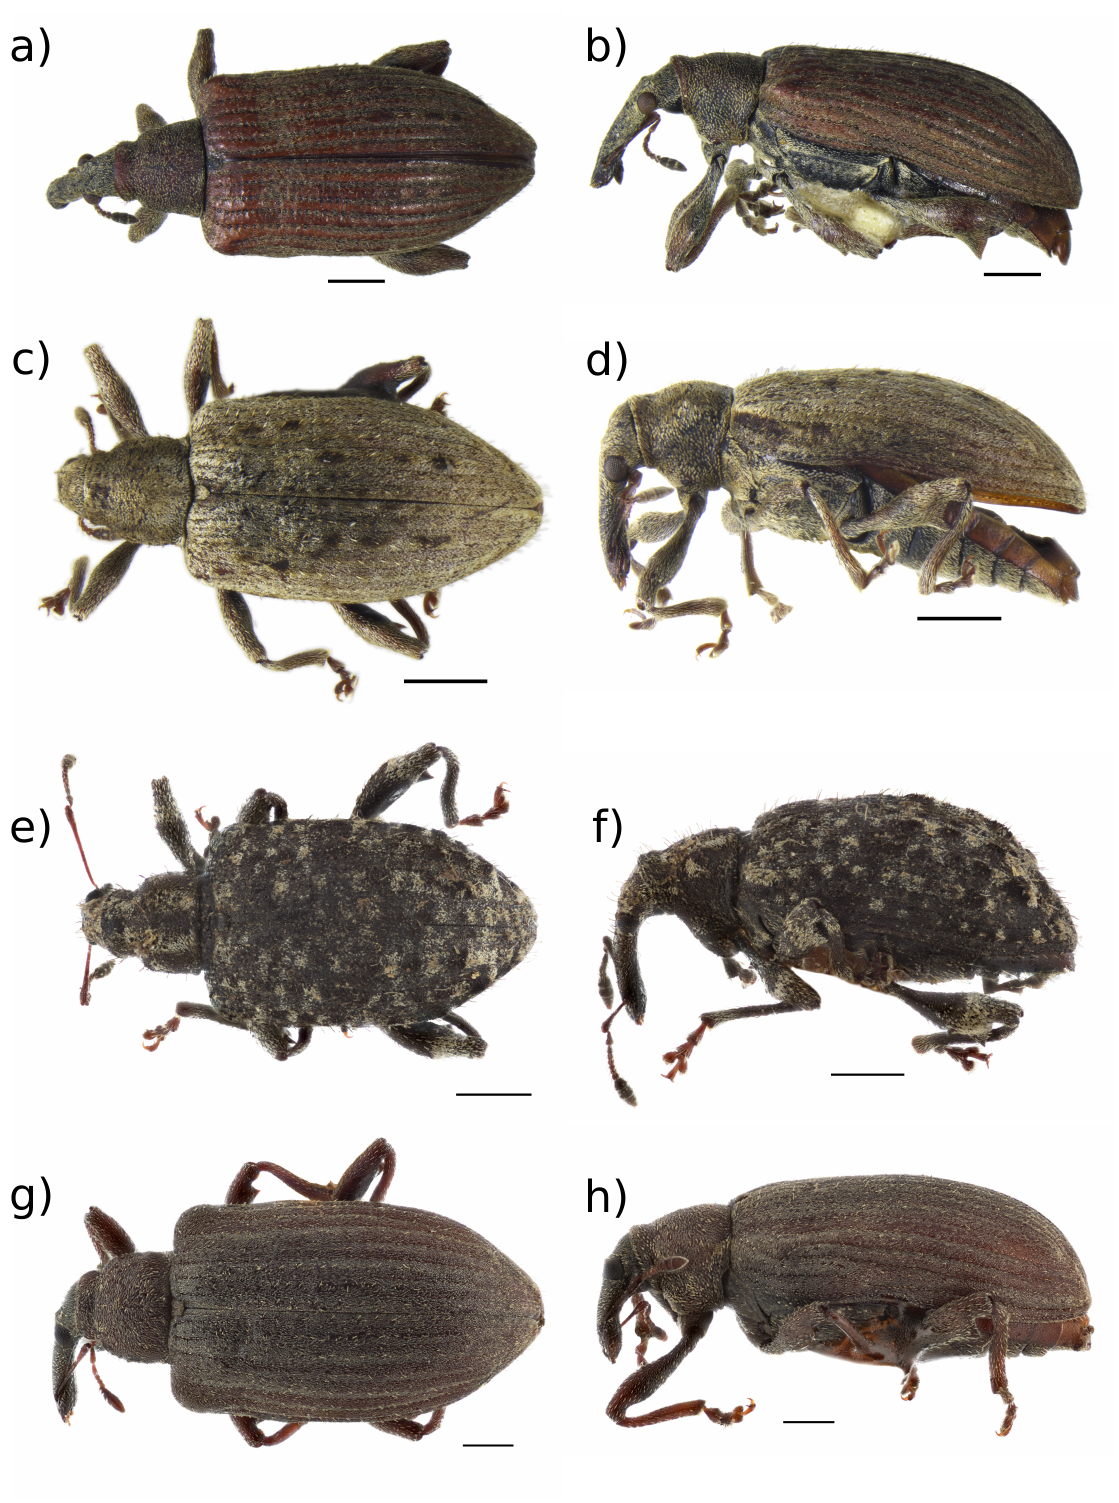
Figure 2. Habitus figures of Kuschelysius species. ( a ) K. hollowayae , dorsal view; ( b ) K. hollowayae , lateral view; ( c ) K. durus , dorsal view; ( d ) K. durus , lateral view; ( e ) K. verbalis holotype, dorsal view; ( f ) K. verbalis holotype, lateral view; ( g ) K. nitens holotype, dorsal view; ( h ) K. nitens holotype, lateral view. Scale bars = 1